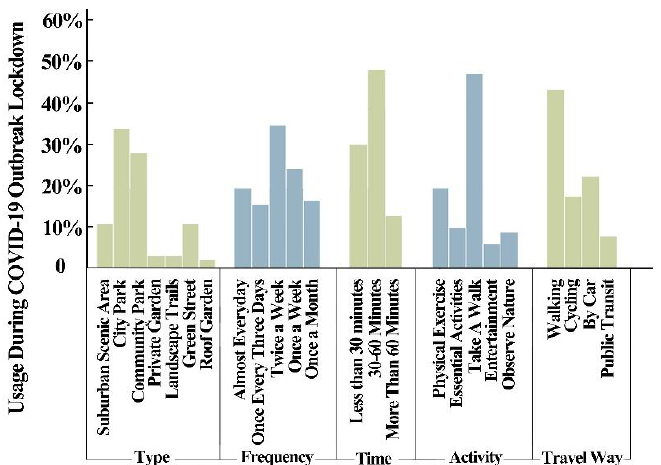
Figure 3. Percentage of usage of the UGSs during the lockdown including types of green spaces visited, visit frequency, time spent, main activity and means of travel.